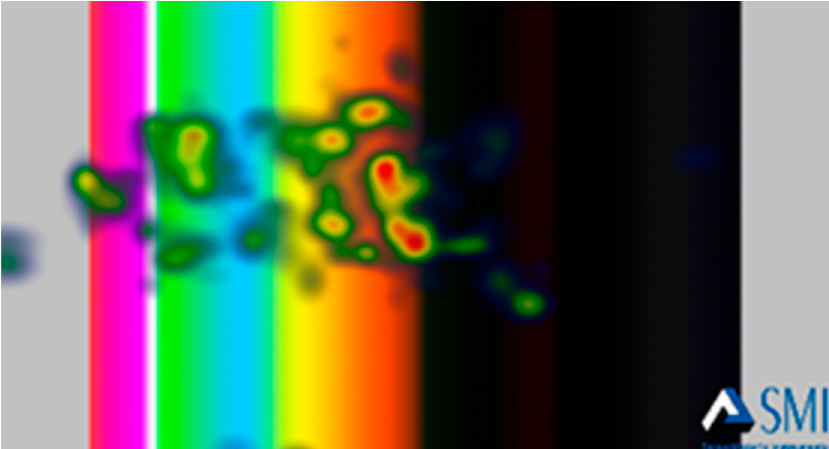
Figure 10. The heat map that demonstrates eye-gaze patterns over the AOIs after displaying a positive stimulus.